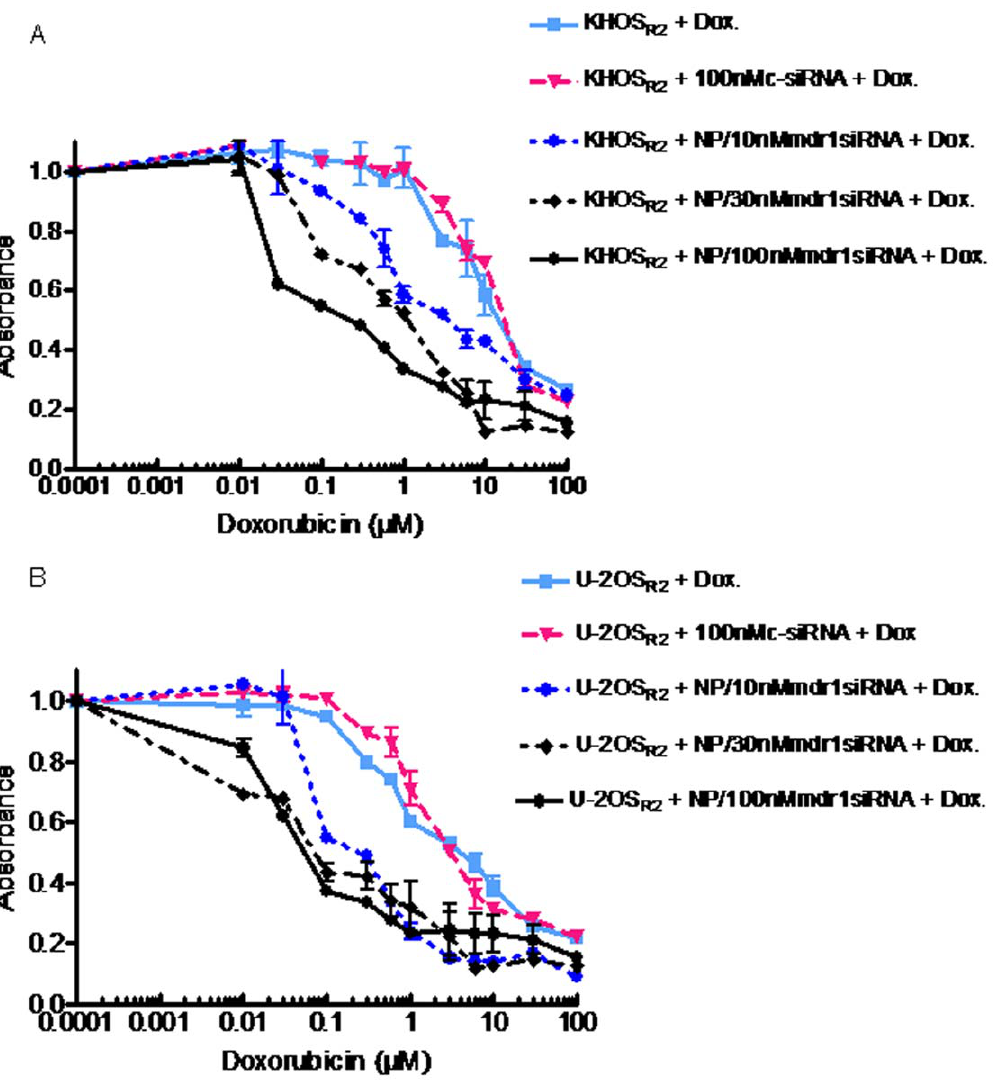
Figure 7. The effect of doxorubicin alone or nanoparticle loaded with MDR1 siRNA on KHOS R2 and U-2OS R2 was analyzed. Varying concentrations of doxorubicin was added and cells were cultured for 5 days. Treatment with nanoparticles loaded with MDR1 siRNA showed increased anti-proliferative activity in both drug resistant osteosarcoma cell lines, KHOS R2 ( A ) and U-2OS R2 ( B ), in a dose dependent manner. Growth inhibition was assessed by MTT as described under Materials and Methods. The experiment was repeated four times in triplicate.